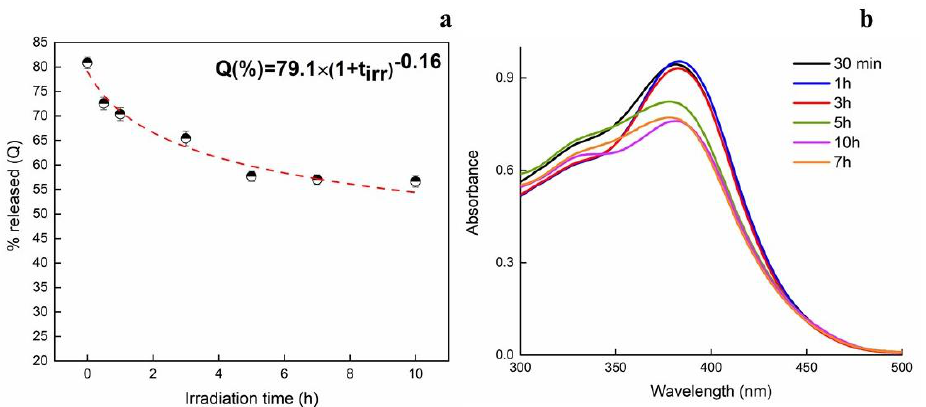
Figure 9. Release of quercetin after 24 h from irradiated samples (left) and UV-Vis spectra of quercetin at different irradiation times (right).